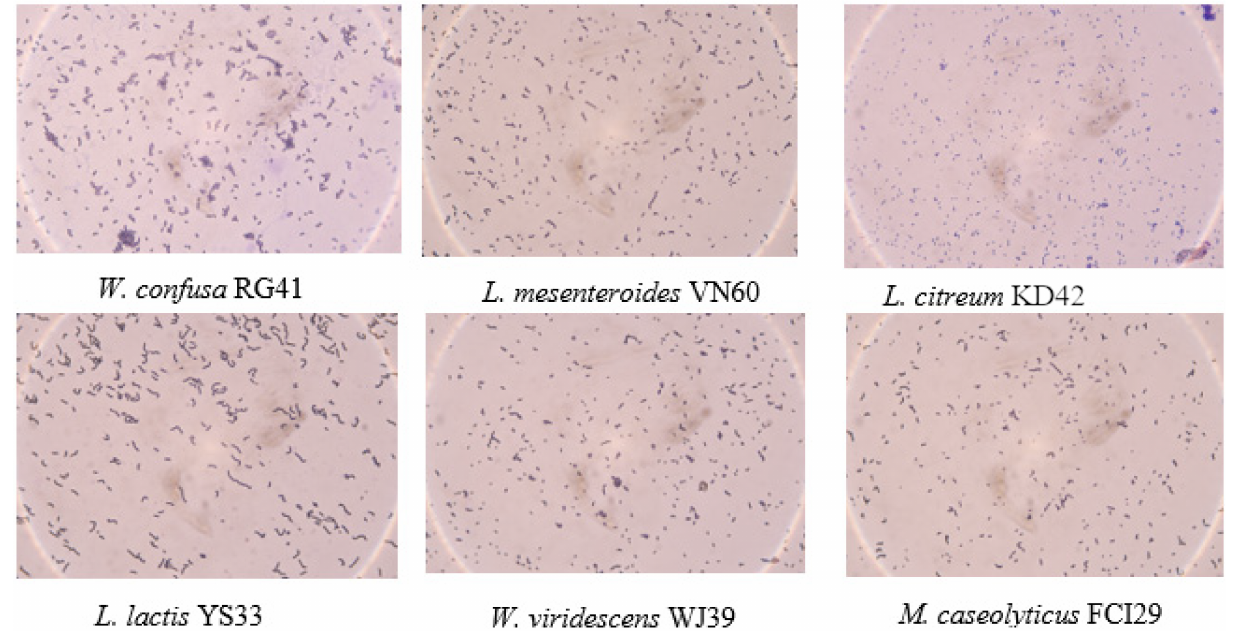
Figure 2. Gram staining of the six bacterial